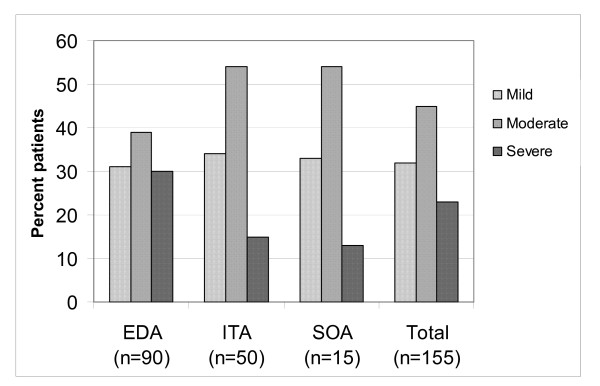
Differences among pain treatment methods with regard to "worst pain" scores.